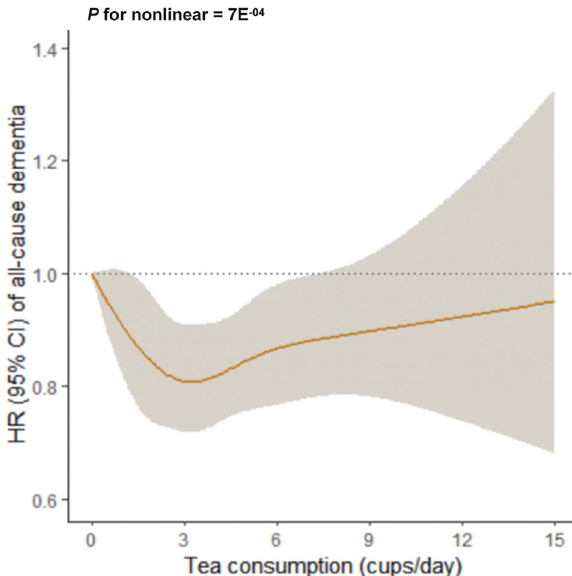
Fig. 4 A non-linear relationship between tea consumption and incident dementia. There was a U-shaped association between tea consumption and incident dementia, and the consumption of around three cups per day showed the strongest protective effect ( P for non-linearity = 7E -04 ). P- value was computed using restricted cubic splines functions in the Cox proportional hazard regression model. The model was adjusted for age, sex, ethnicity, TDI, education, BMI, typical sleep duration, smoking status, alcohol status, total consumption of vegetables, total consumption of fruit, total consumption of fi sh and APOE4 status. HR Hazard ratios,